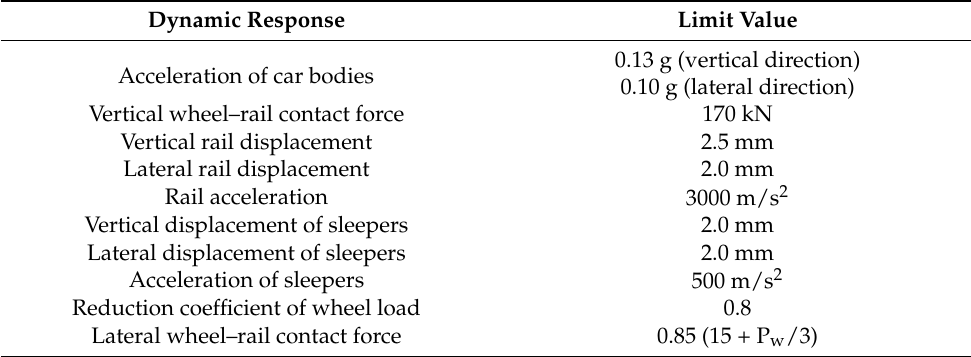
Table 2. Limiting values of dynamic responses of high-speed rail track